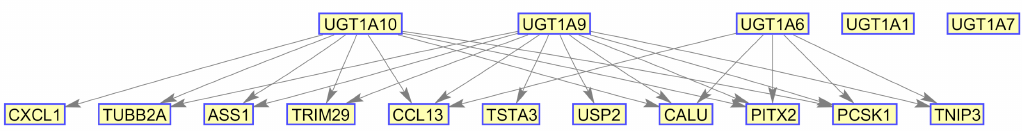
Figure 1. GRN generated from the application of partial least square based feature selection (PLSNET) on the inflammatory bowel disease (IBD)